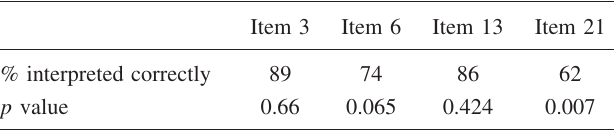
TABLE IV. Fisher’s exact probability test results for distribution of consistent and inconsistent results when comparing items with consistency level less than 90% to the average 94%